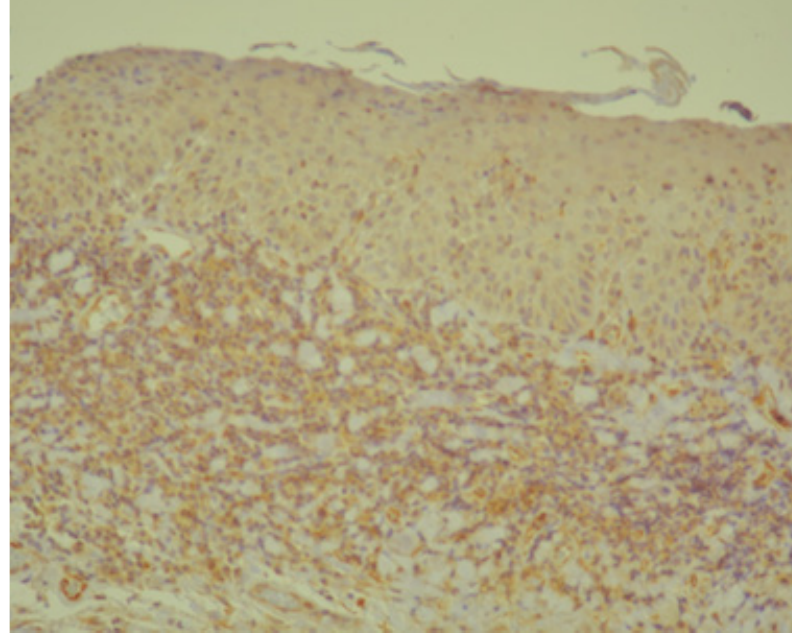
Figure 3. IL-6—moderate brown staining in epithelium (all layers) and strong staining in stroma of oral epithelial dysplasia (OED) (20x). J. Clin. Med. 2020 , 9 , x FOR PEER REVIEW